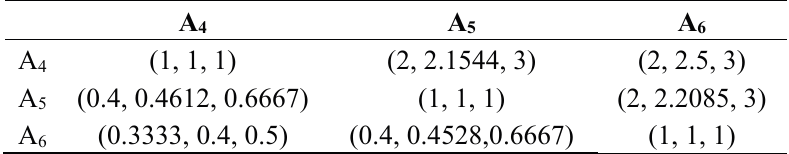
Table 10. The group judgment matrix of the attributes within the “function”